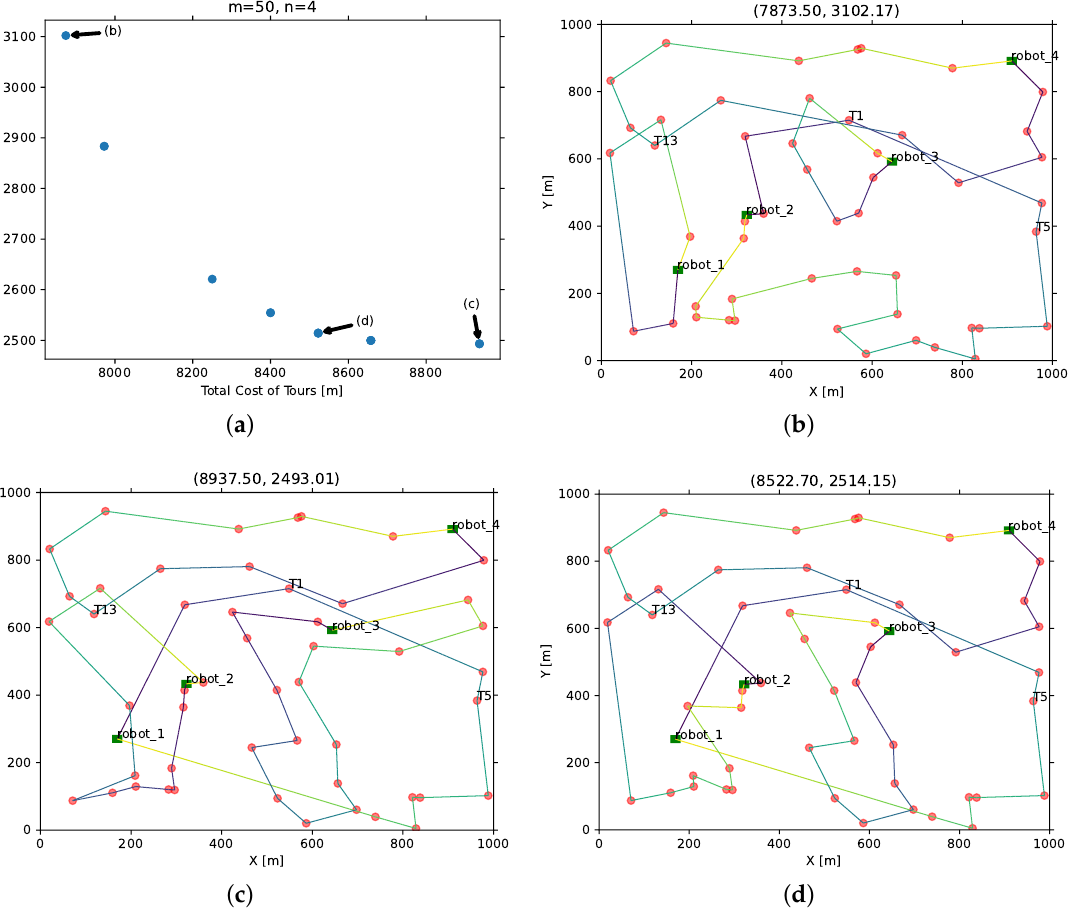
Figure 6. An instance of MD-MRTA with constraints: ( a ) Pareto front, ( b – d ) different solutions of task allocation and route planning for each